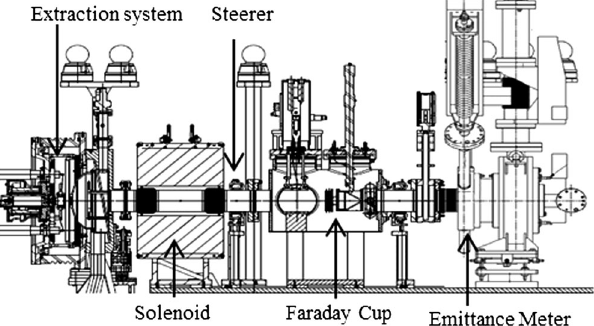
current.FIG. 1. Experimental setup for beam properties measurements at the Linac4 test